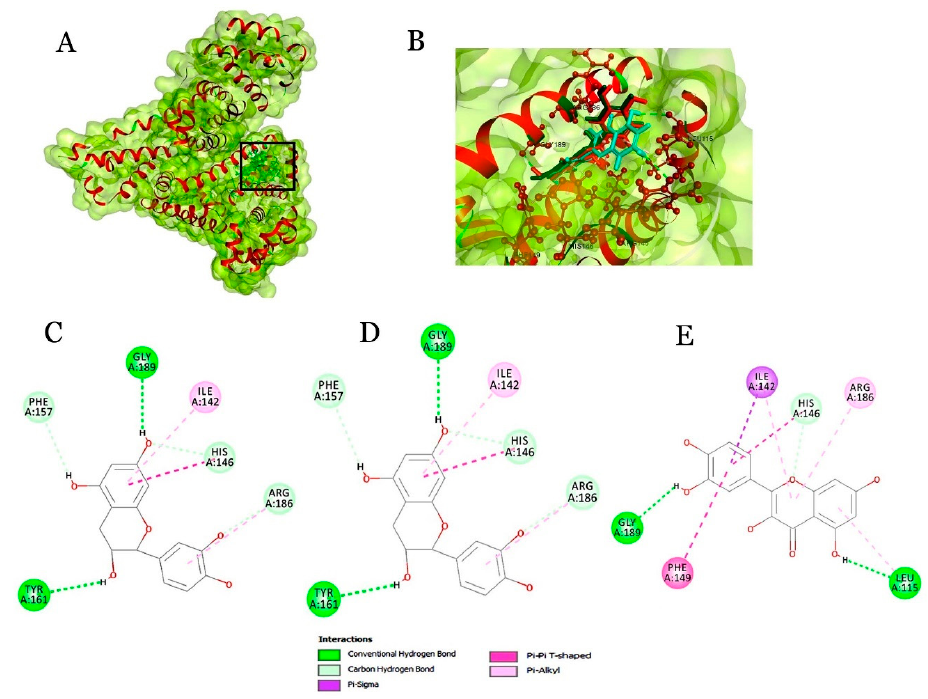
Figure 2. In silico docking of HSA. ( A ) Interaction of the ligands into binding pocket (black box) of HSA; ( B ) Expanded view representing ligands interacting with the amino acids of the receptors (ball and stick model); 2D plot for interaction of catechin ( C ), epicatechin ( D ) and quercetin ( E ) with HSA. Molecules 2020 , 25 , x FOR PEER REVIEW Overall, flavonoids show the highest dock score compared to the phenolic compounds and the residues implicated in the interactions were LEU46, TYR53, GLN86, ALA90, ASN131, PHE132 and GLN133 (Figure 3).